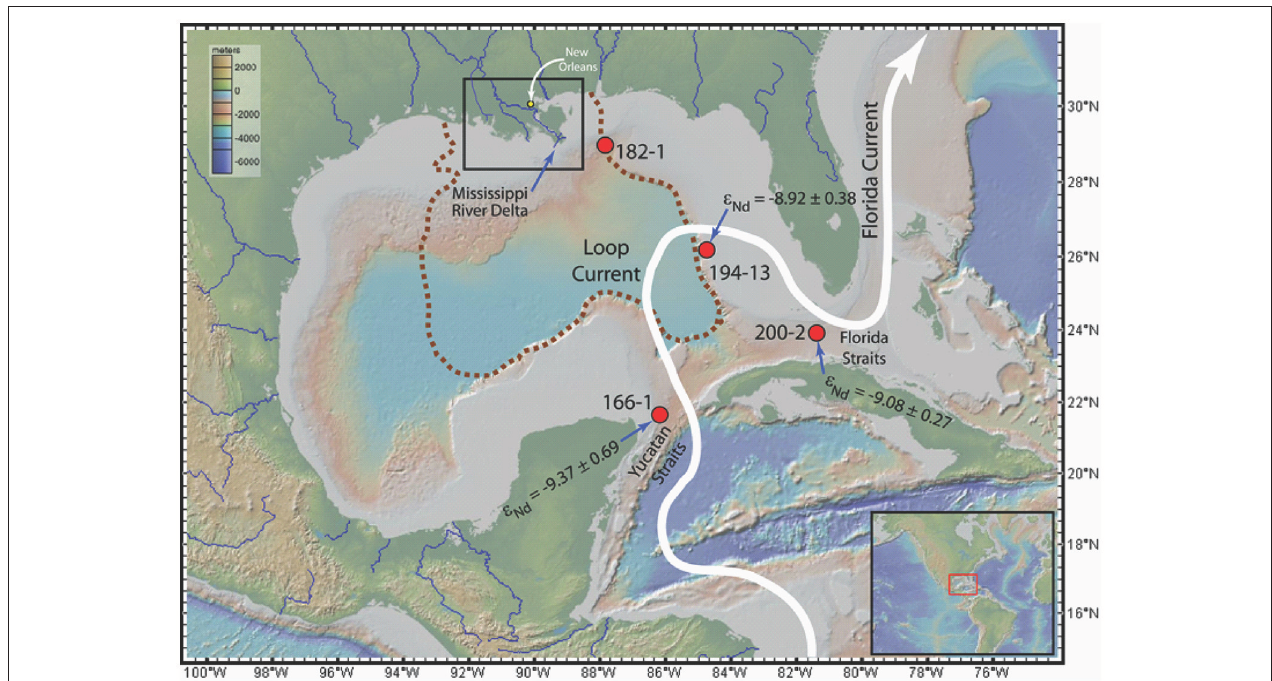
FIGURE 8 | Map of the Gulf of Mexico showing the locations of water column profiles (red circles) for REE and ε Nd(0) from Osborne et al. (2014, 2015), the Gulf region subject to deposition of Mississippi River sediment (brown dashed line; Trefry and Shokes, 1981), and generalized track of the Loop Current (thick white arrow). The study area (black rectangle around the MR delta) is shown in more details in Figure 1 . The mean and standard error (see text for details) of the ε Nd(0) measured in the water column in the Yucatan Straits, the eastern Gulf, and the Florida Straits (Osborne et al.,